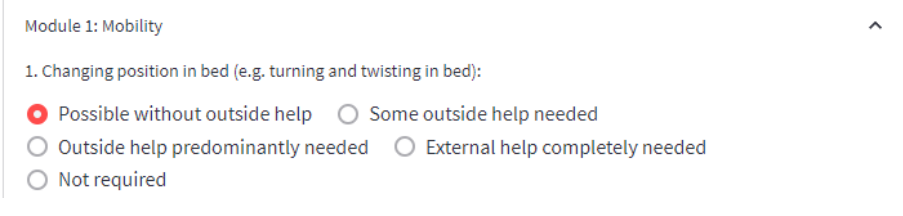
Figure 4. Proof-of-concept